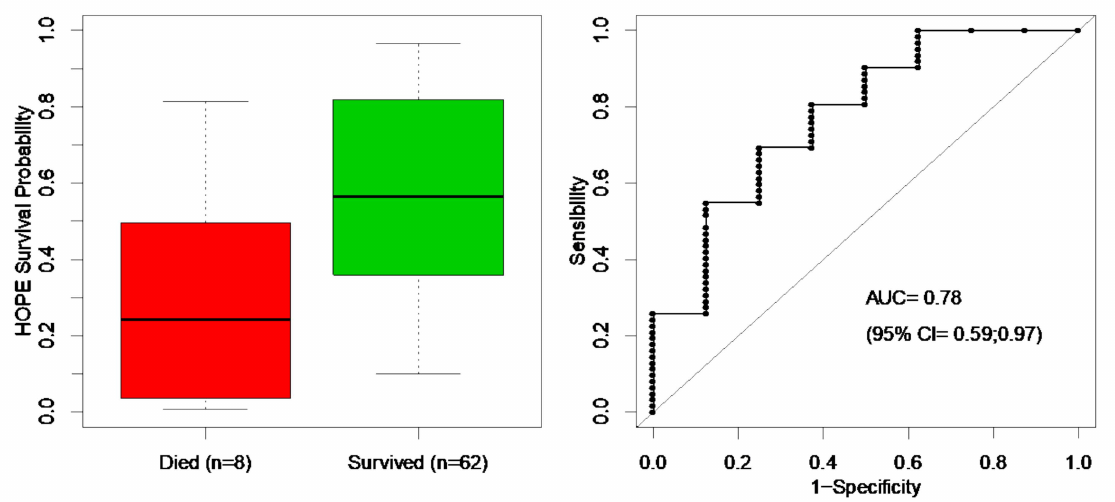
Figure 2. Hypothermia outcome prediction after extracorporeal life support (HOPE) survival probabilities ( left panel ) and receiver operating characteristic curve ( right panel ) of the survival probabilities estimated from 70 patients. The average HOPE survival probability was 57% for survivors (in green) and 30% for non-survivors (in red). AUC = area under the curve; CI = confidence